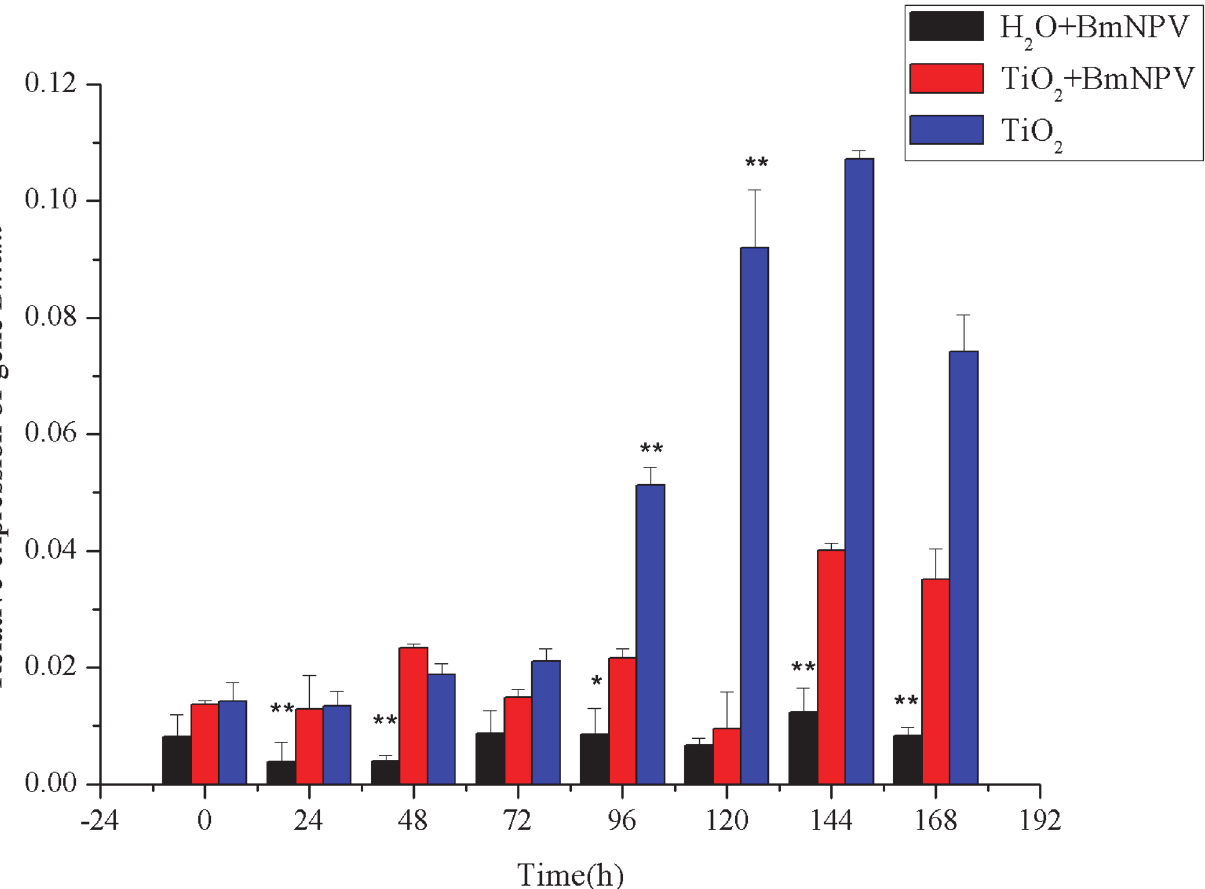
Fig 9. Relative expression of Bmakt . Black and red histograms represent the control group and the experimental group, respectively, and blue histograms represent the TiO 2 NPs-treated group. X and Y axes represent the time after infection and the relative expression of Bmakt , respectively. The bars in the figure with different letters indicate statistically significant differences ( p <